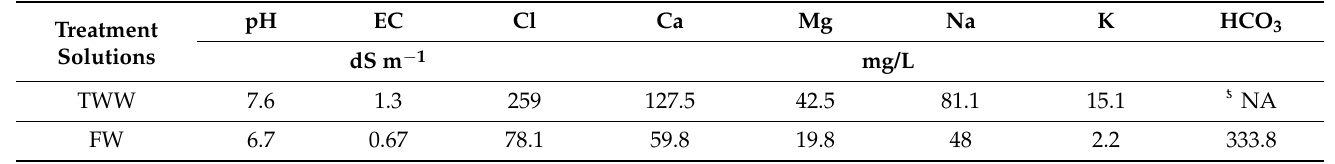
Table 2. Typical electrical conductivity (EC), pH values, and concentrations of various ions in the treated wastewater (TWW) and fresh water (FW) that were used in the region of the Yarkon-Taninim aquifer [15]. Treatment Solutions